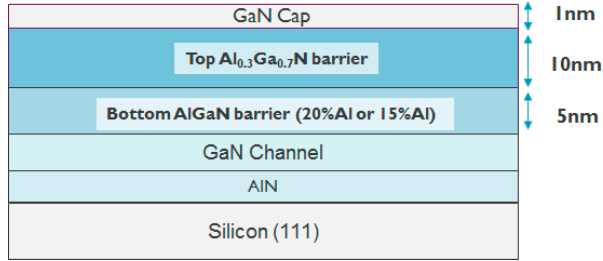
Figure 1. Schematic of the epitaxy structure with a double AlGaN barrier used in this study.